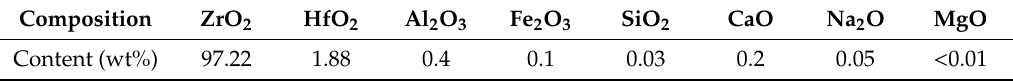
Table 6. Chemical composition of ZrO 2 prepared from the basic zirconium sulfate precipitate. Composition